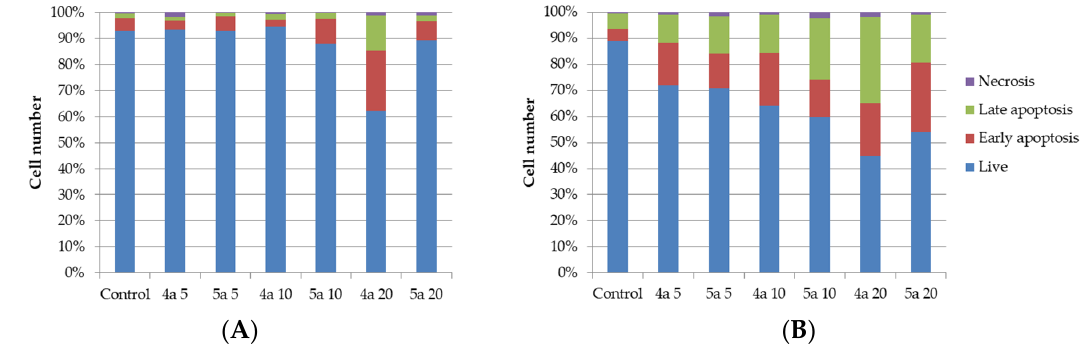
Figure 3. Annexin V-FITC/Propidium iodide (PI) dual staining assay of K562 ( A ) and HeLa ( B ) cells treated with cy- cloadducts 4a and 5a at concentrations 5, 10 and 20 μ g/mL using flow cytometry.